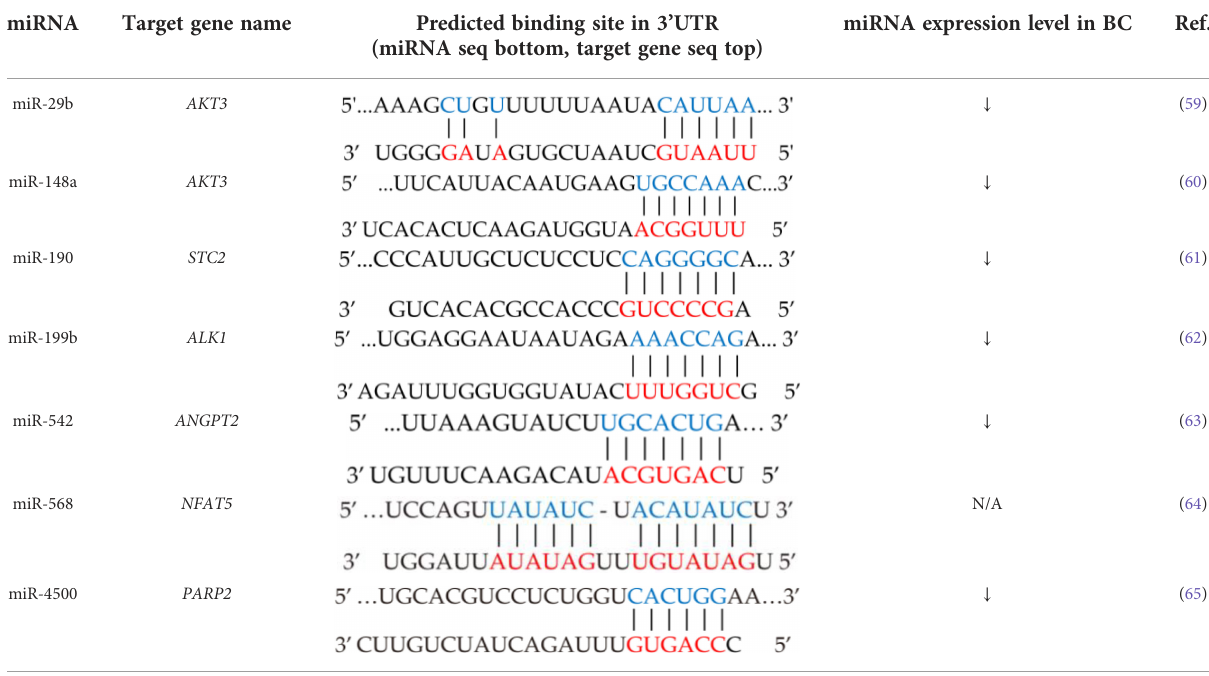
TABLE 2 Anti-angiogenic miRNAs in breast cancer and their target